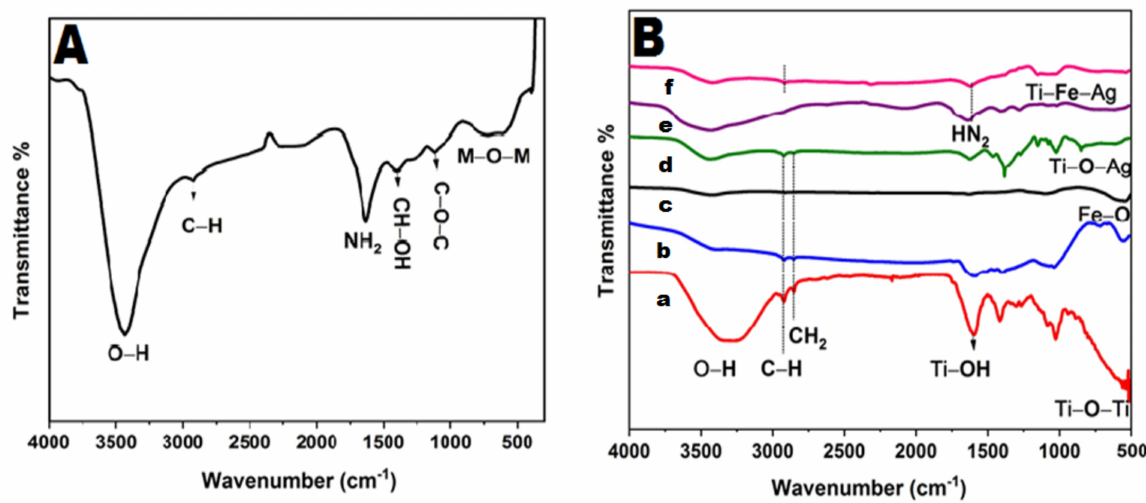
Figure 4. FTIR of synthesized nanomaterials. ( A ) M. concanensis leaves; ( B ) TiO 2 NPs ( a ), Fe 2 O 3 NPs ( b ), Ag NPs ( c ), Ag/TiO 2 nanohybrid ( d ), CS NPs ( e ), CIP-Ag/TiO 2 /Fe 2 O 3 /CS nanoformulation (NDDS) ( f